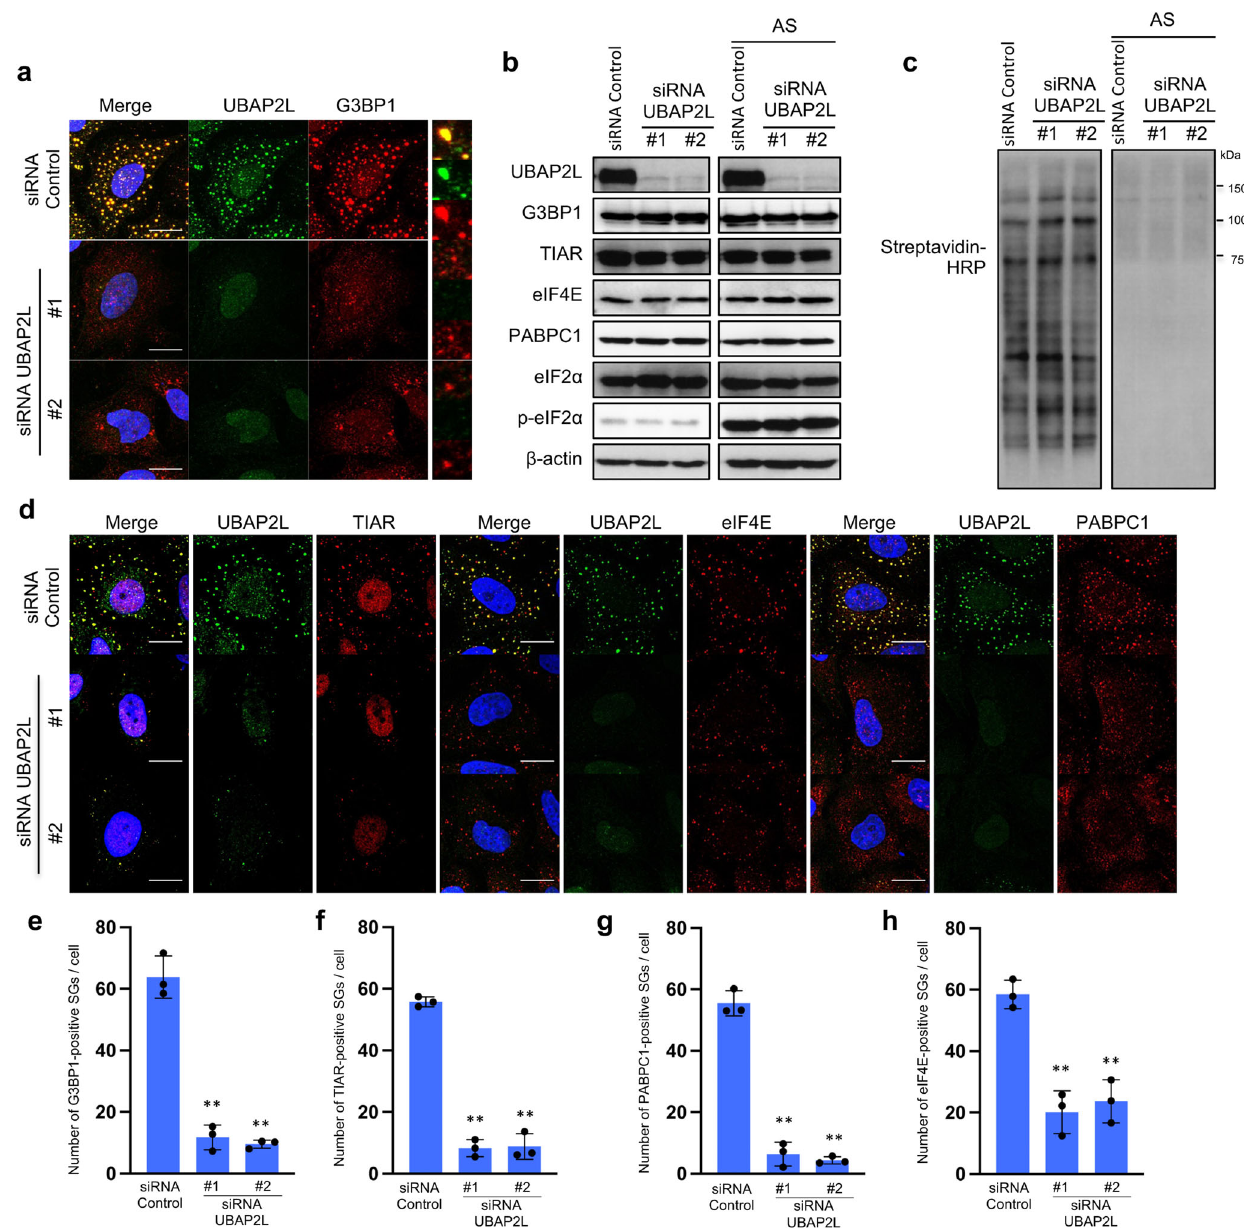
Fig. 2 UBAP2L is essential for SG assembly. a HeLa cells were transfected with control or UBAP2L siRNAs, and 72 h later, the cells were treated with 0.5 mM arsenite for 30 min and immunostained with anti-UBAP2L and anti-G3BP1 antibodies (scale bar = 10 μ m). b Cells were transfected with the indicated siRNAs, and 72 h later, cells were treated with or without 0.5 mM arsenite for 30 min and lysed. The expression of UBAP2L, G3BP1, TIAR, eIF4E, or PABPC1 was examined by immunoblot. c Cells were treated with L-azidohomoalanine (AHA) with or without arsenite for 30 min, and lysed. The lysates were reacted with a Click-it Biotin Protein Analysis Detection Kit according to manufacturer ’ s protocols. The reacted samples were immunoblotted with an anti-streptavidin-HRP antibody. d Cells transfected with siRNAs were treated as in a and immunostained for TIAR, eIF4E, or PABPC1 and UBAP2L (scale bar = 10 μ m). e – h The numbers of SGs positive for each indicated SG marker per cell are presented in the graph. Three independent experiments were performed and 5 cells were evaluated for each experiment. (** P <